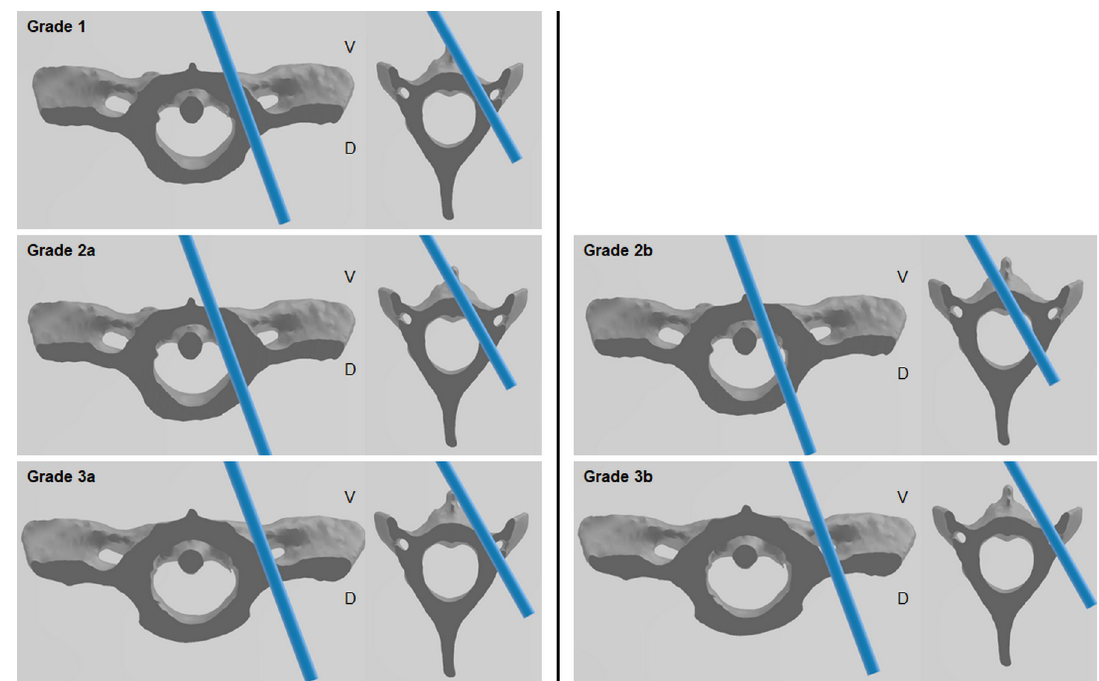
Fig 4. Transverse images of C1 and C2 with pedicle screw trajectories in place. Grading of the screw position by Zdichavsky modified classification. Grade 1: fully contained within the pedicle and vertebral body. Grade 2a: medial pedicle wall penetration. Grade 2b: entirely medial to the pedicle wall. Grade 3a: partial lateral breaching. Grade 3b: full lateral breaching. Lateral breaching was defined as an intrusion into the C1 transverse foramen or C2 transverse foramen and breach of the C2 lateral cortex.